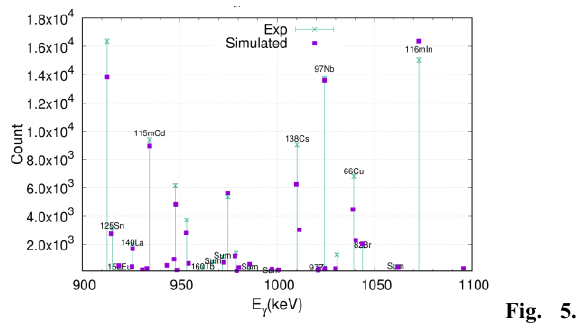
Simulated gamma counts compared with the measured.